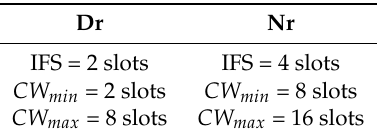
Table 1. Contention parameters.